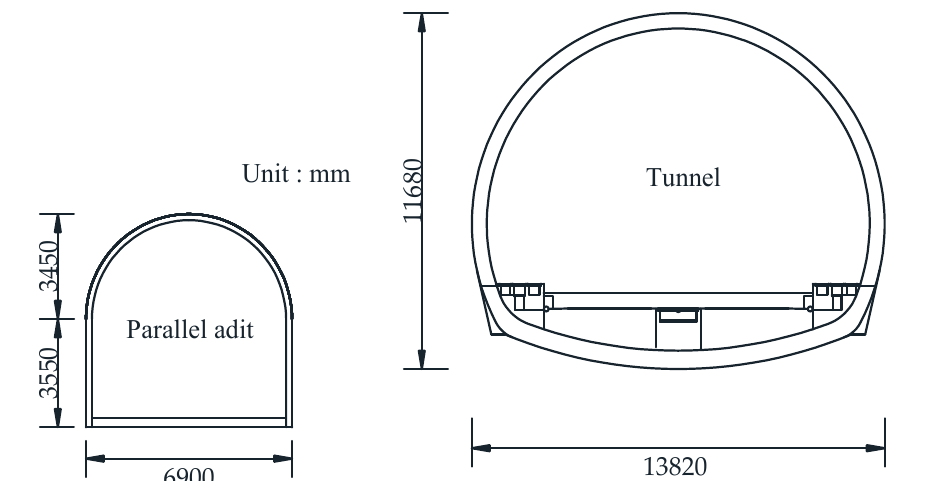
Figure 6. Hydrogeological profile of the Jiajiaoshan Tunnel.